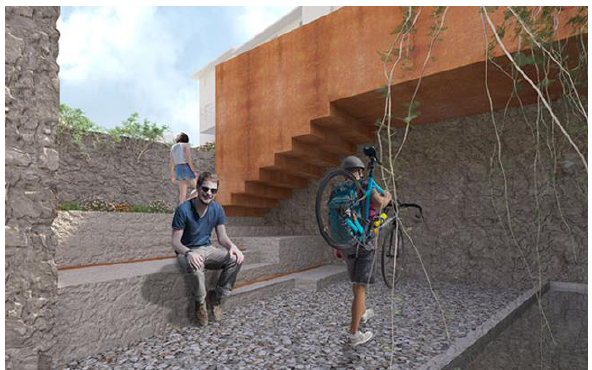
Figure 7. Render of the